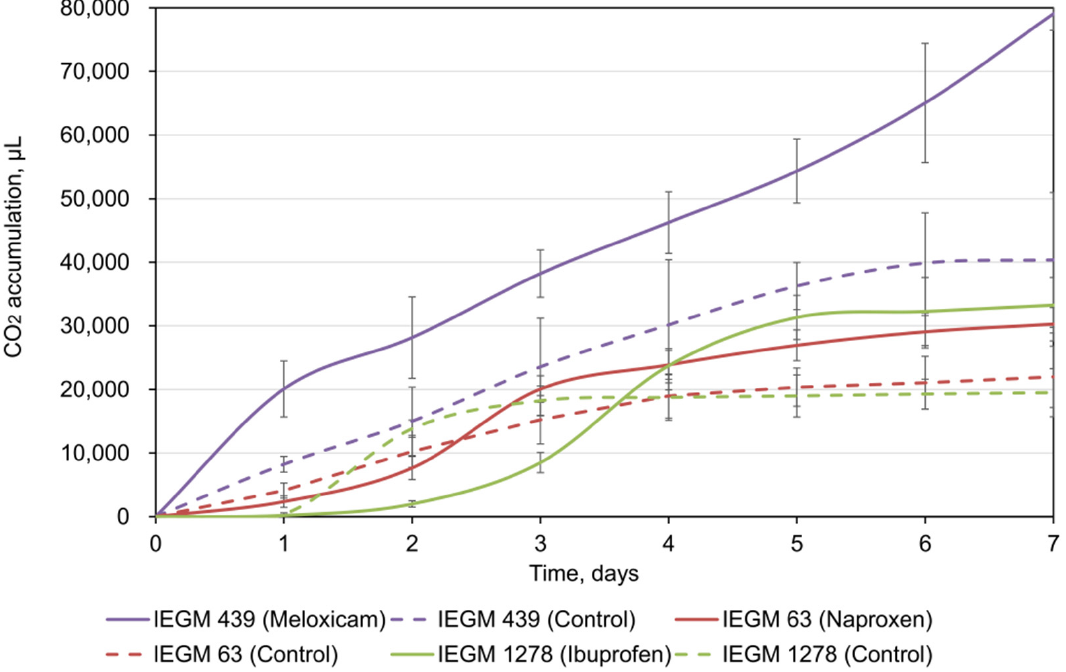
Figure 1. CO 2 accumulation by rhodococci during NSAID bioconversion. The data are presented as mean values ± standard deviations ( n = 3).